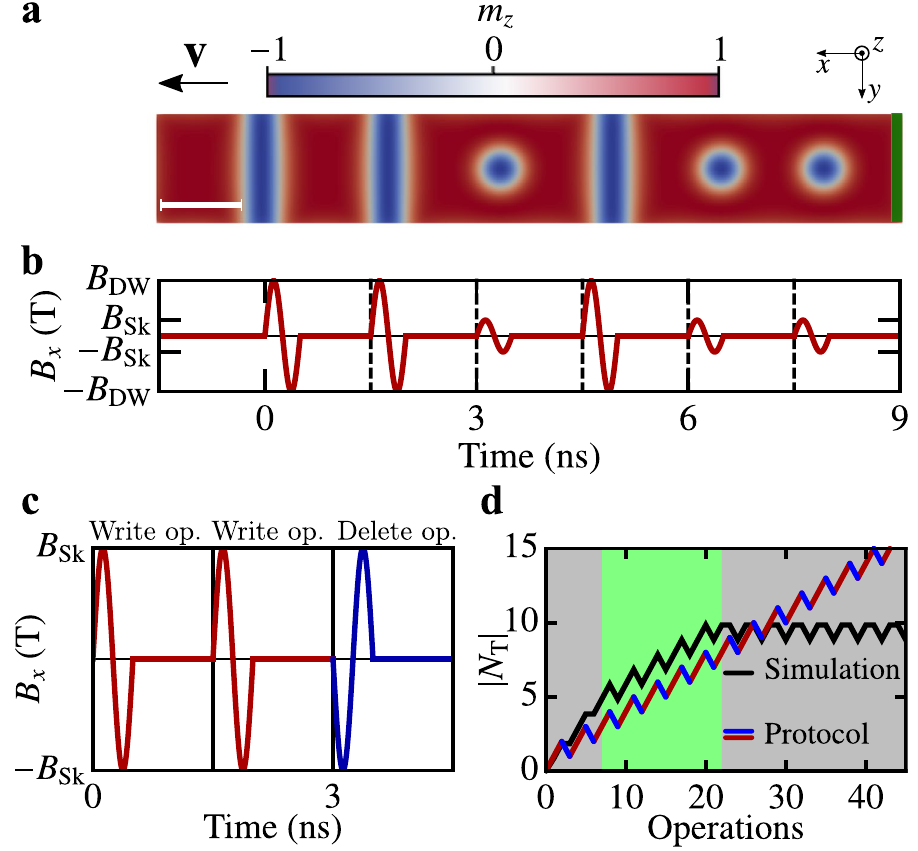
Figure 4. Writing and deleting operations. ( a ) Mixed sequence of three DWs and three skyrmions generated by multiple different field operations in the green area. ( b ) In-plane component of the rotating effective magnetic field with two different amplitudes. ( c ) Field protocol B x ( t ) for two writing operations (red) and one deletion operation (blue) with rotational sense opposite to the DMI. ( d ) Simulated total topological charge (black line) as a function of the number of subsequent field operations according to the protocol shown in ( c ). In the bright green area, the simulated topological charge is parallel to the behavior of an ideal system exactly following the protocol (red/blue line), therefore indicating high reproducibility. System size: 200 × 30 × 1 c 3 , with material parameters corresponding to